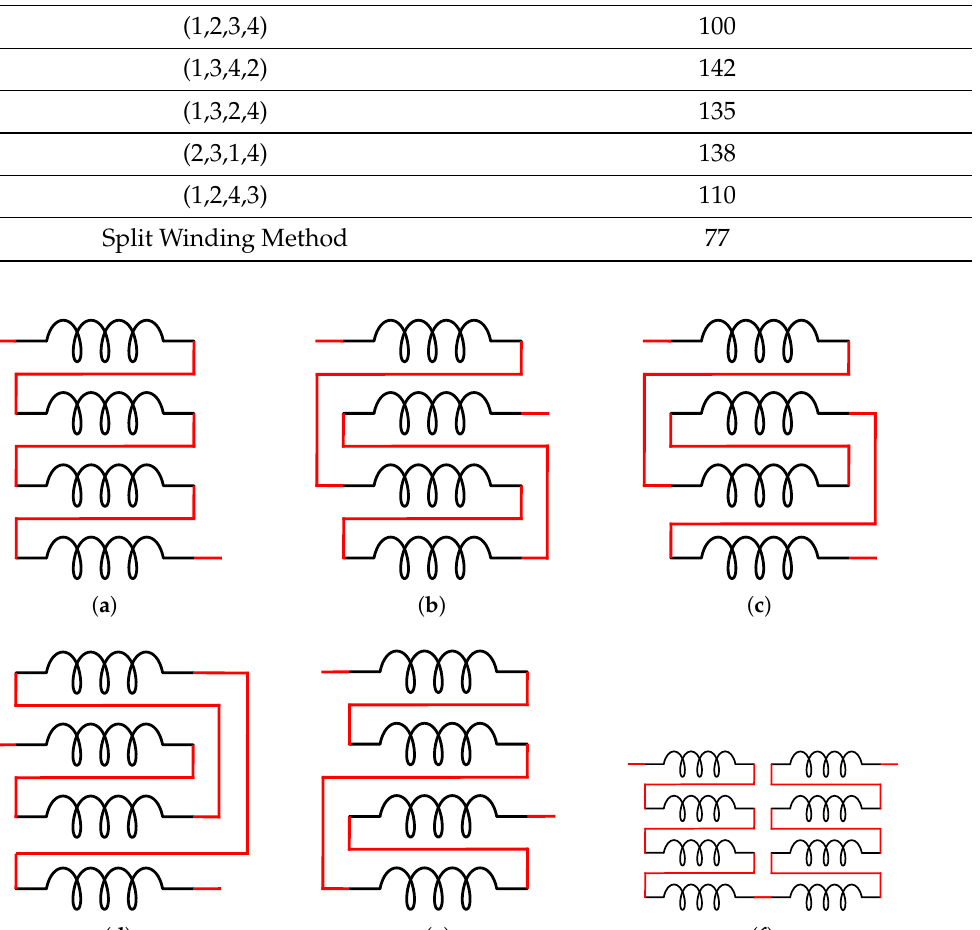
Figure 19. Various series connections of PCB layers as windings to reduce capacitive coupling. This allows for the inductors to be wound in a way that allows them to be split into multiple layers, which reduces the amount of capacitive coupling between the layers. This leads to a more efficient inductor and better performance. ( a ) (1,2,3,4), ( b ) (1,3,4,2), ( c ) (1,3,2,4), ( d ) (2,3,1,4), ( e ) (1,2,4,3), and ( f ) split winding connections